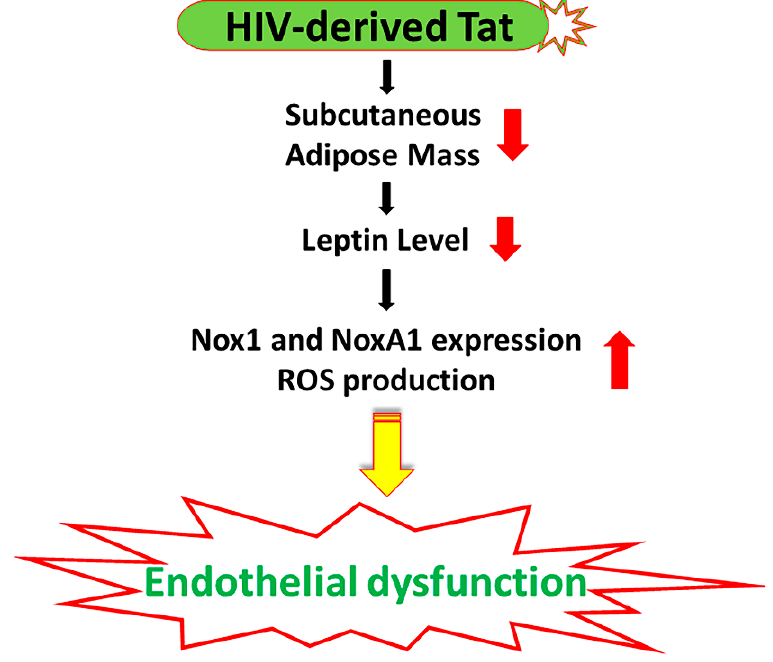
Figure 5. Schematic illustrating the possible mechanisms whereby HIV-derived protein Tat reduces adipose mass and plasma leptin levels leading to increased Nox1 and NoxA1 expression and ROS production and ultimately contributes to endothelial